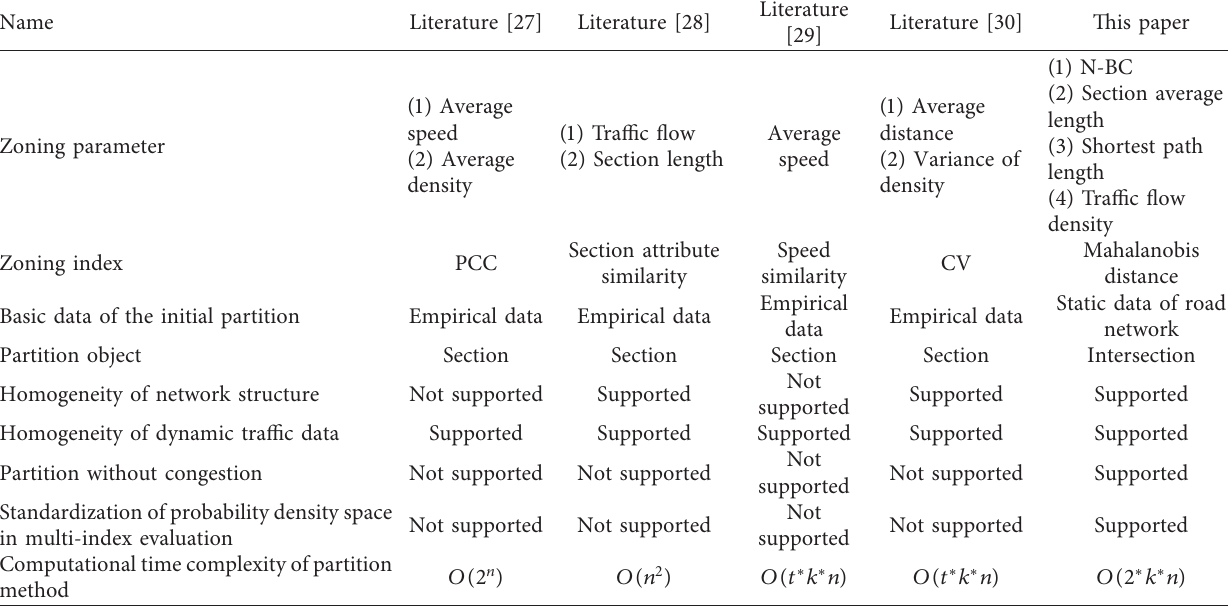
Table 8: The partition method in this paper is compared with other partition methods.